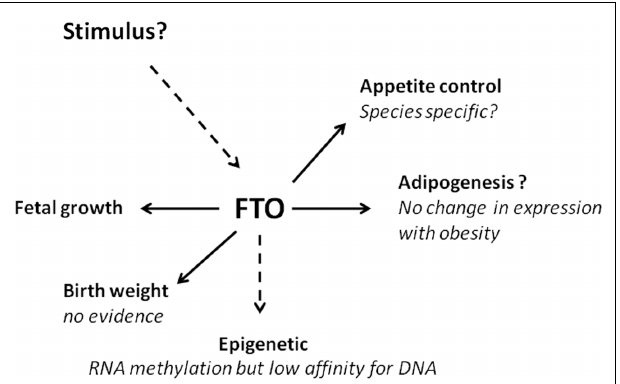
FIGURE 2 |The FTO gene – future research challenges. Summary of the main effects and regulators of the Fto gene and its potential role in the onset of